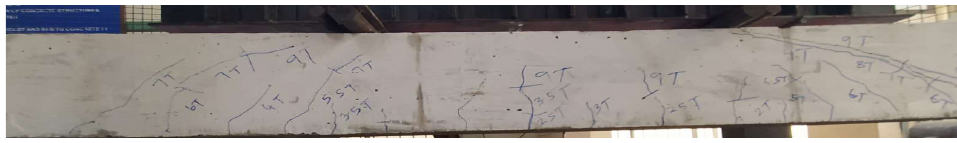
Figure 13. WWM 15 mm square reinforced LWC beam.